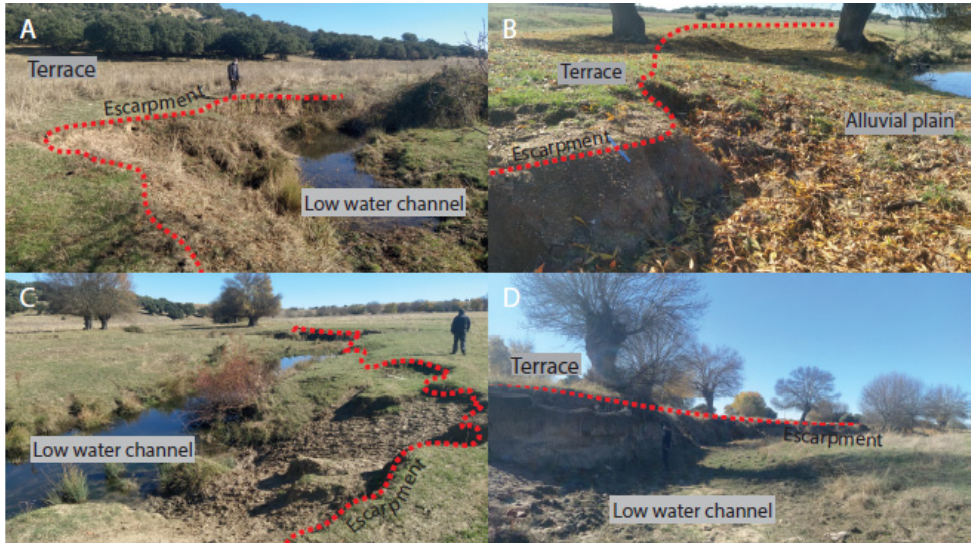
Figure 4. Topographic evidence identified in the field: ( A – C ) Escarpments marking erosion margins; ( B ) Escarpment of a low terrace; ( D ) Low-water channel escarpment (erosion zone).